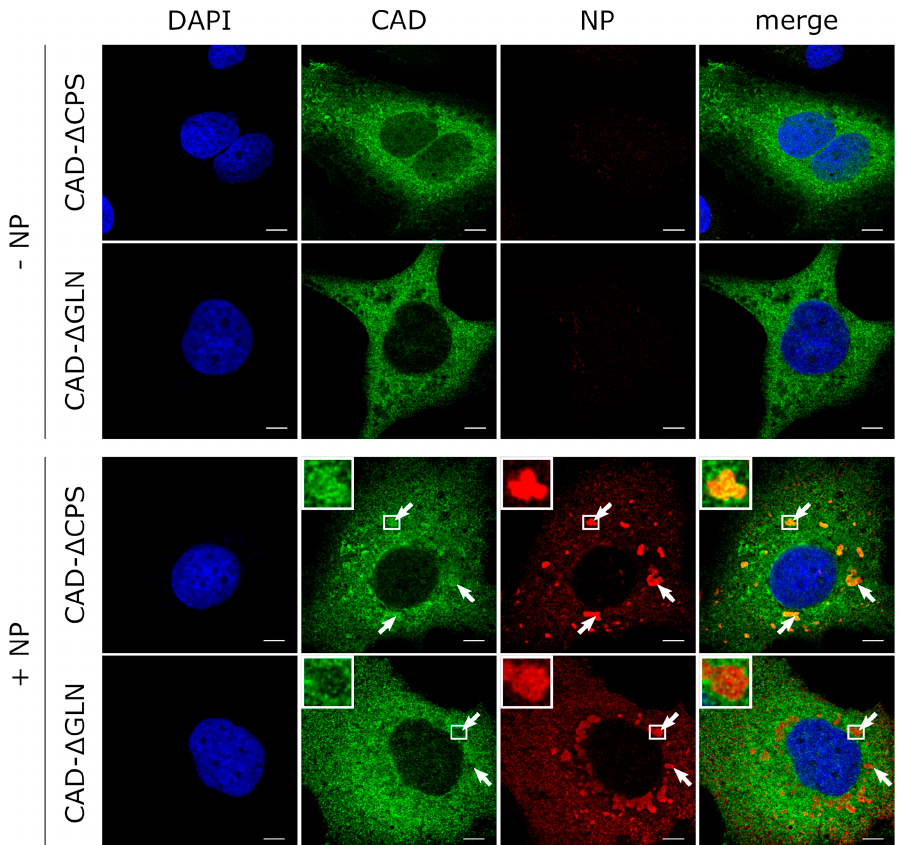
Figure 6. Recruitment of CAD deletion mutants into inclusion bodies. Huh7 cells overexpressing FLAG / HA-CAD- ∆ GLN, FLAG / HA-CAD- ∆ CPS and EBOV-NP, as indicated, were fixed with 4% PFA and permeabilized with 0.1% Triton X-100 48 h post-transfection. FLAG-tagged CAD (shown in green) was detected using an anti-FLAG antibody and NP (shown in red) was stained with EBOV anti-NP antibodies. The nuclei were stained with DAPI (shown in blue), and the cells were visualized by confocal laser scanning microscopy. Scale bars indicate 10 µ m. The arrows point out inclusion bodies, and the insets show magnifications of the indicated areas. Merge shows an overlay of all three channels.